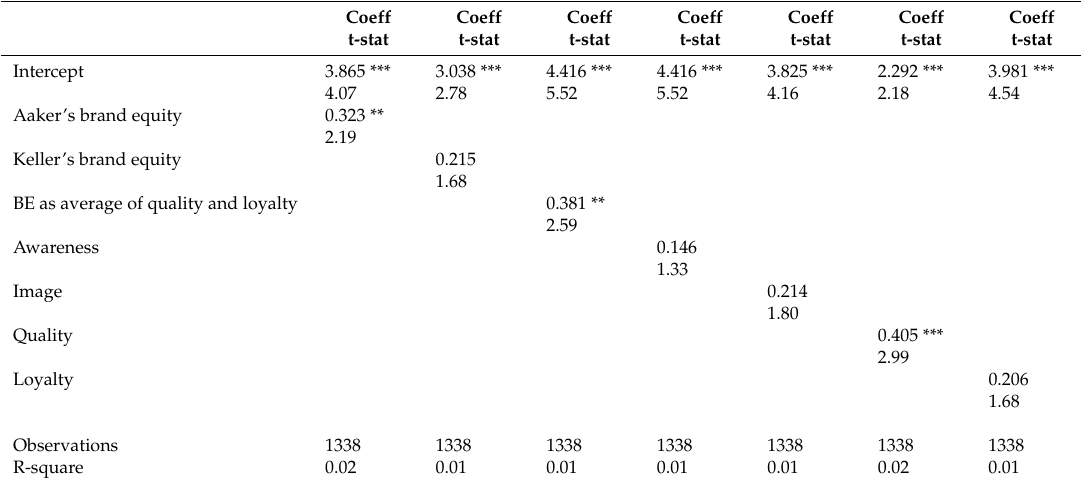
Table 4. Relation between brand equity (and components) and